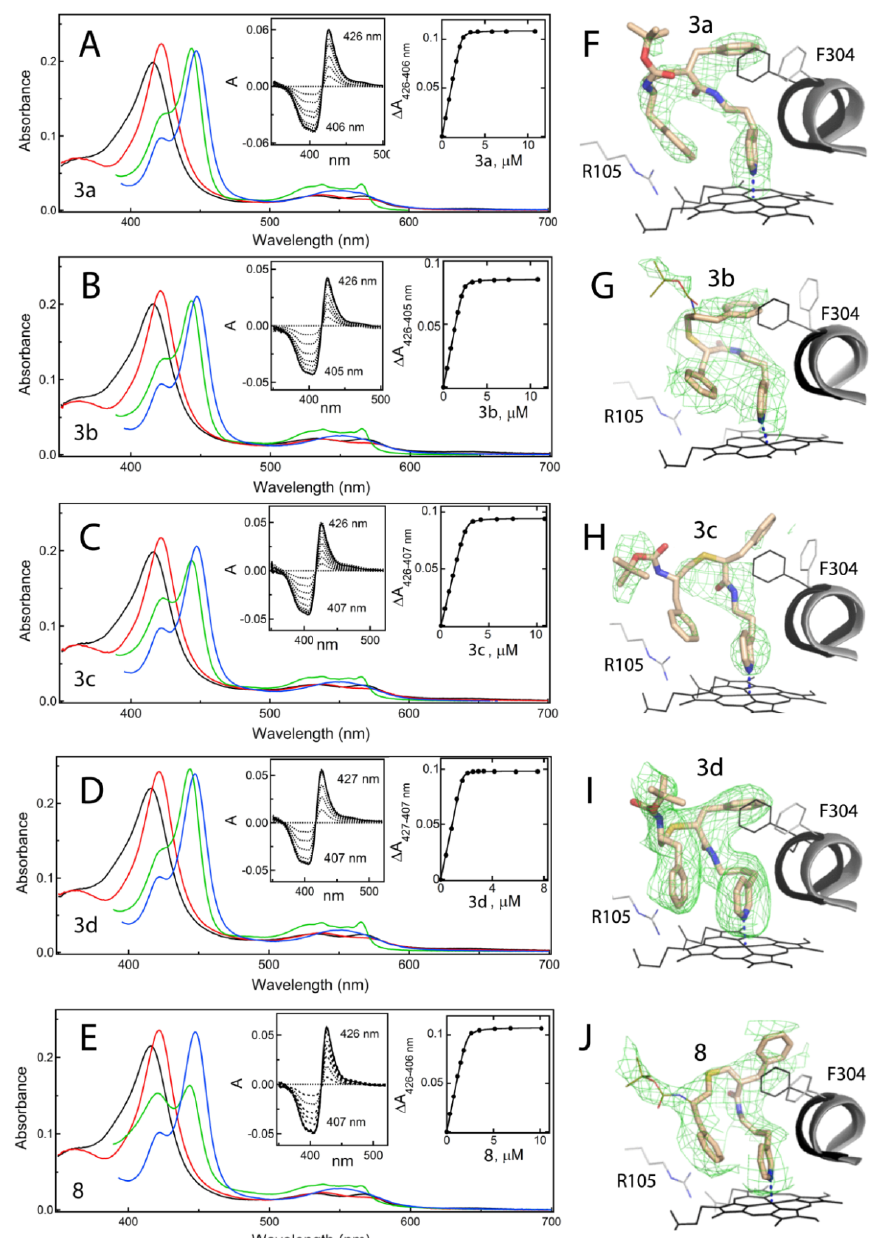
Figure 3. Spectral properties and the binding modes of 3a – d and 8 . ( A – E ) Spectral changes induced in cytochrome P450 (CYP) by 3a – d and 8 . Absorbance spectra of ferric ligand-free and inhibitor-bound CYP3A4 are in black and red, respectively. Spectra of ferrous ligand-bound CYP3A4 and its CO-adduct are in green and blue, respectively. Left insets are difference spectra recorded during equilibrium titrations; right insets are titration plots with quadratic fittings. The derived spectral dissociation constants (K s ) are given in Table 1. ( F – J ) The binding modes of 3a – d and 8 observed in the crystal structures. Carbon, oxygen, nitrogen and sulphur atoms are depicted in beige, red, blue and yellow, respectively. The R / S conformer of 8 ( rac , S ) was selectively co-crystallized with CYP3A4. The adjacent I-helix and F304 in the inhibitory complexes and water-bound CYP3A4 (5VCC structure) are depicted in gray and black, respectively. Polder omit maps are contoured at 3 σ level and shown as green mesh. Tail-groups of 3b and 8 that could not be traced in the electron density maps are shown as thin lines.